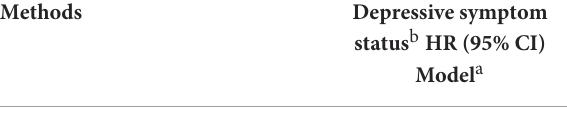
TABLE 6 Association of vision and hearing scores with depressive symptoms stratified by different risk factors using